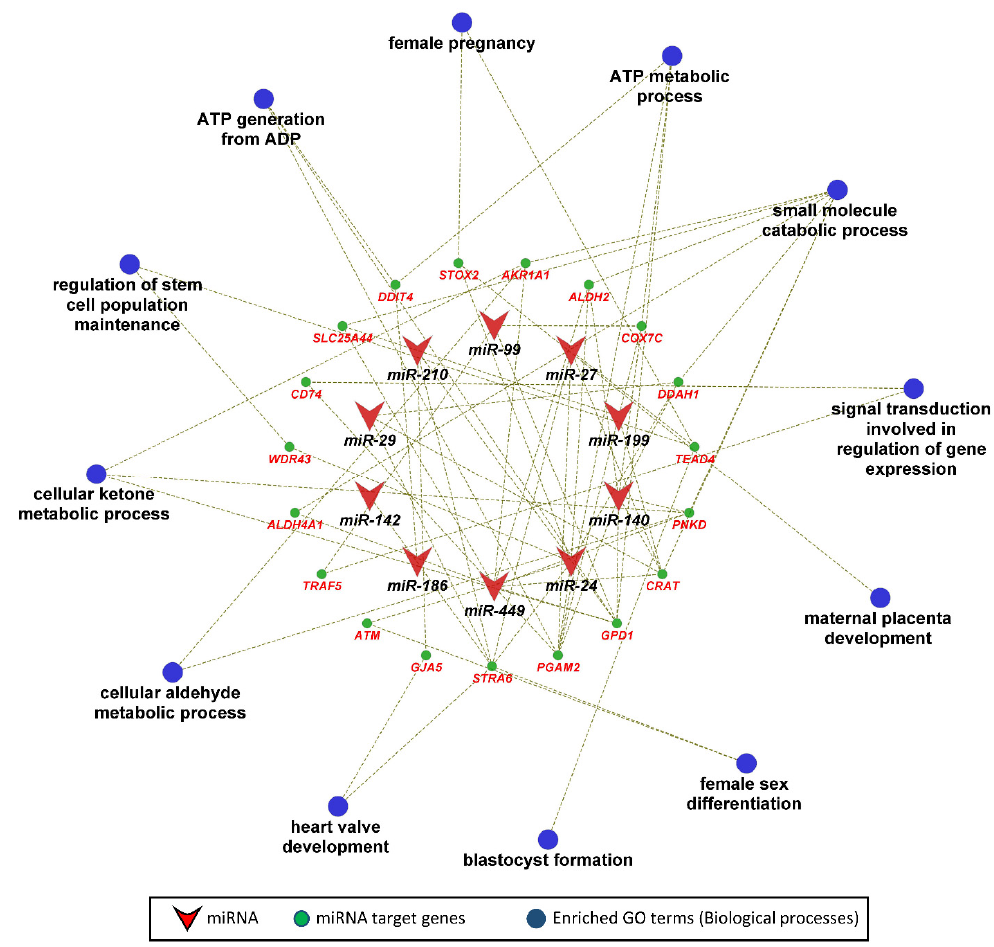
Figure 6. Gene ontology enrichment analysis, with a focus on biological processes, of fetal weight-correlated target genes of fetal weight-correlated miRNAs. Biological processes with a p ≤ 0.05 were considered significantly enriched. A complete list of biological processes significantly enriched by miRNA target genes is provided in Table S6.